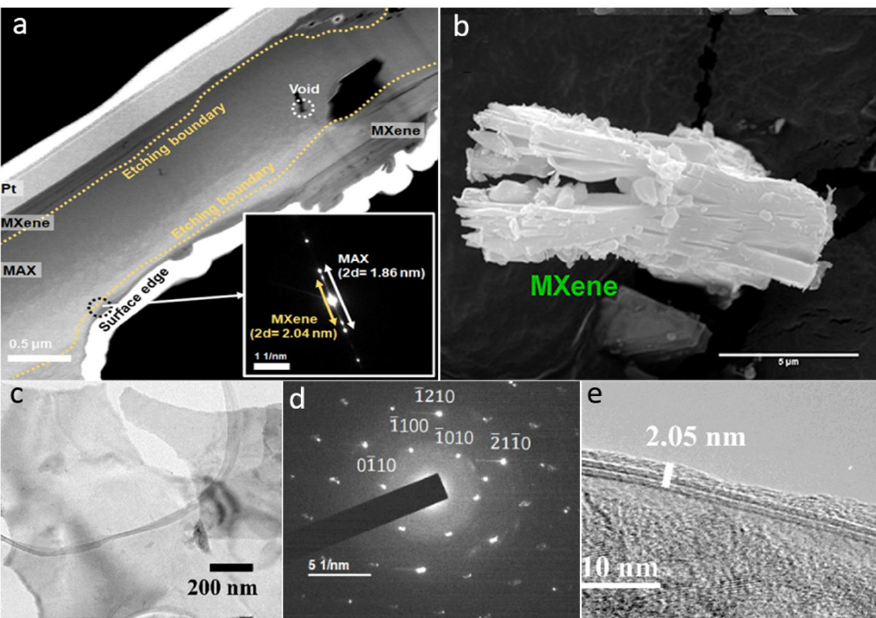
Figure 3. ( a ) STEM micrograph of the bulk-etched MAX phase Ti 3 AlC 2 for 3 h and the corresponding SAED pattern as inset. Reproduced with permission from ref. [36] Copyright 2021, The American Chemical Society. ( b ) The SEM micrograph of CoF 3 /MAX without any AlF 3 ·3H 2 O impurity. Reproduced with permission from ref. [38] Copyright 2019, The American Chemical Society. ( c ) TEM micrograph, ( d ) the corresponding SAED pattern, and ( e ) HR-TEM micrograph of the MS-Ti 3 C 2 T x . Reproduced with permission from ref. [42] Copyright 2022, The American Chemical Society.